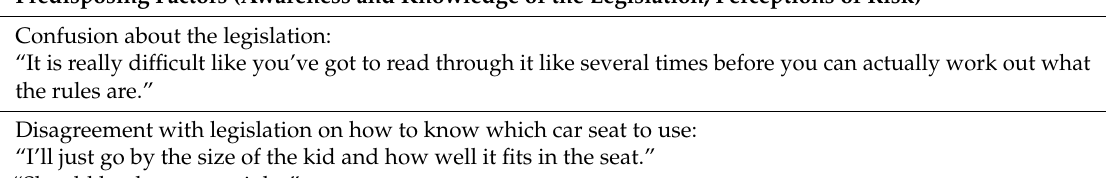
Table 3. PRECEDE-PROCEED framework applied to describe factors affecting car seat use reported by parents in focus